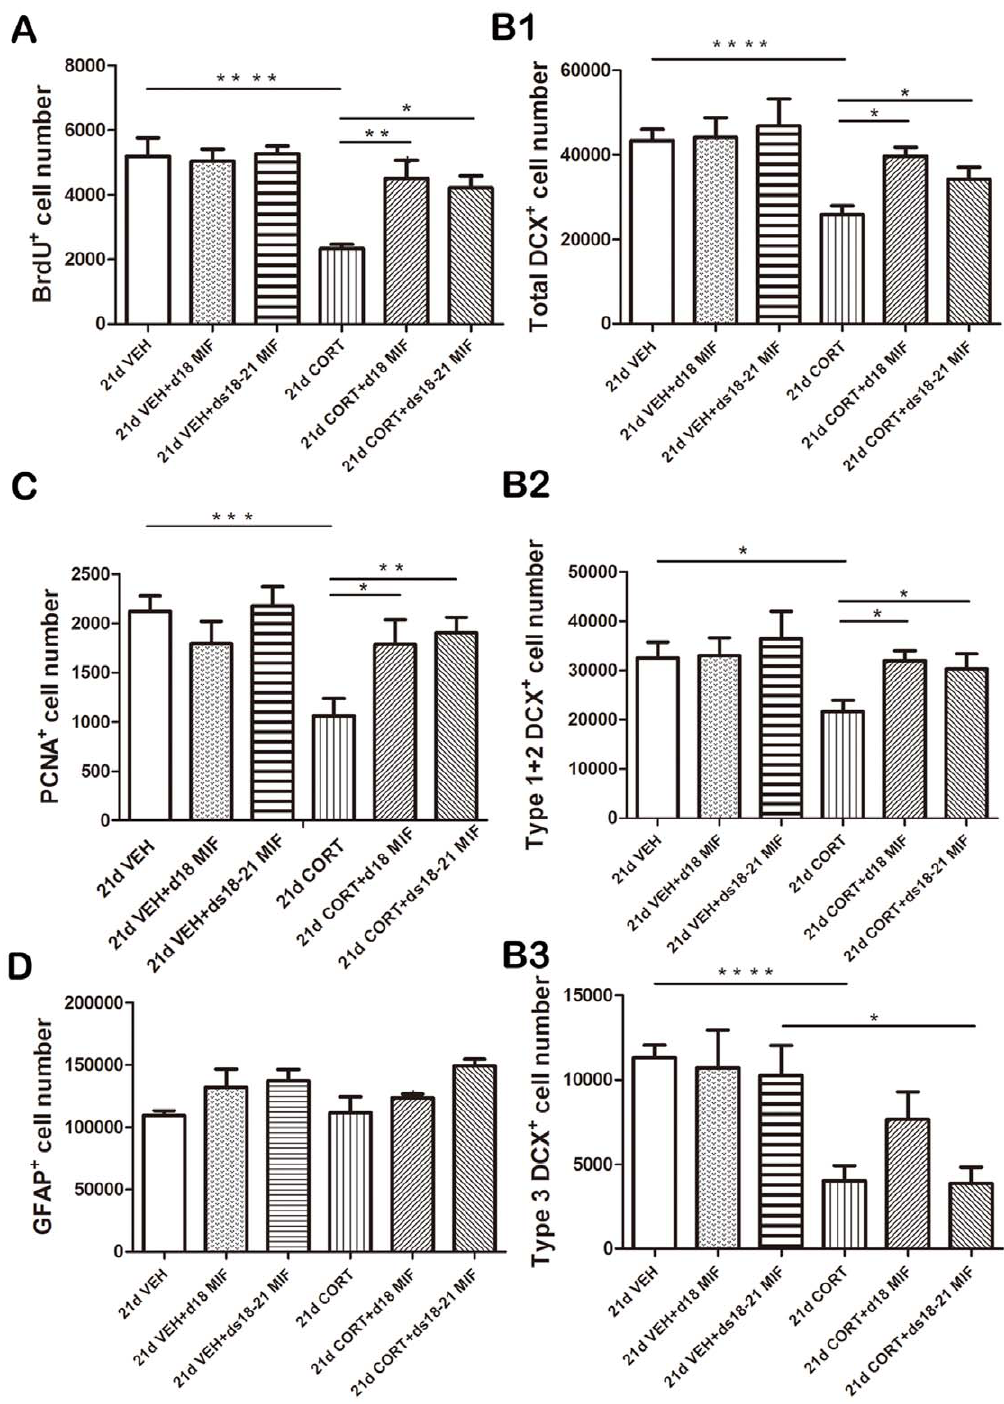
Figure 4. Effects of mifepristone given at d18 only or during ds18–21 of 3-weeks corticosterone treatment period. A. Mifepristone treatment during ds 18–21 fully normalizes the CORT-induced reduction in number of BrdU + cells (p , 0.05 compared to 21 ds CORT + d18–21 VEHM). Surprisingly, mifepristone treatment only on d18 also normalized the CORT-induced reduction (p , 0.01). No significant difference was found between these two treatment groups (21ds CORT + ds18–21 MIF versus 21ds CORT + d18 MIF; p . 0.05). Mifepristone treatment was entirely ineffective in the vehicle (VEHC) control groups. B1. Mifepristone treatment either during ds 18–21 (p , 0.05) or only on d18 (p , 0.05) normalized the CORT-induced reduction in DCX + cells. These two treatment groups (21ds CORT + ds18–21 MIF versus 21ds CORT + d18 MIF) yielded comparable numbers of DCX + cells. B2. Mifepristone treatment either during ds 18–21 (p , 0.05) or only on d18 (p , 0.05) was effective in normalizing the CORT-induced reduction in immature DCX + cells. B3. Mifepristone was ineffective in restoring the CORT-induced reduction in the number of mature DCX + cells (p . 0.05 in both treatment groups). CORT-treated animals receiving mifepristone for 4 days (21ds CORT + ds18–21 MIF) still had a significantly lower number of mature DCX + cells than the corresponding vehicle group (p , 0.05 vs 21ds VEHC + ds18–21 MIF). C. Mifepristone administration either on d18 alone (p , 0.05) or during ds18–21 (p , 0.01) normalized CORT-induced reduction in PCNA + cells. Again, mifepristone treatment had no effect in the VEHC